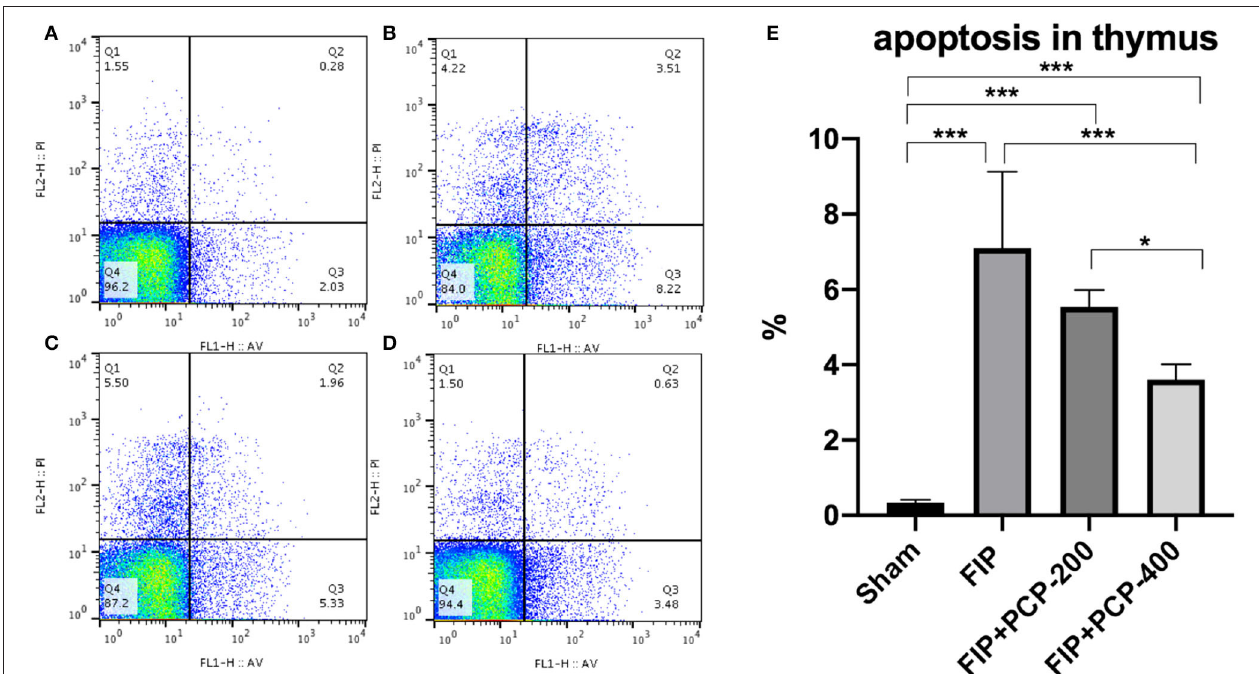
FIGURE 7 | The impact of PCP on apoptosis in the fecal peritonitis-induced septic thymus. PCP pretreatment contributed to decreased Annexin-V, PI. (A) Sham group; (B) FIP; (C) FIP + PCP-200; (D) FIP + PCP-400. (E) Histogram of four groups. As shown, the differences between FIP and FIP + PCP-400 had a significant